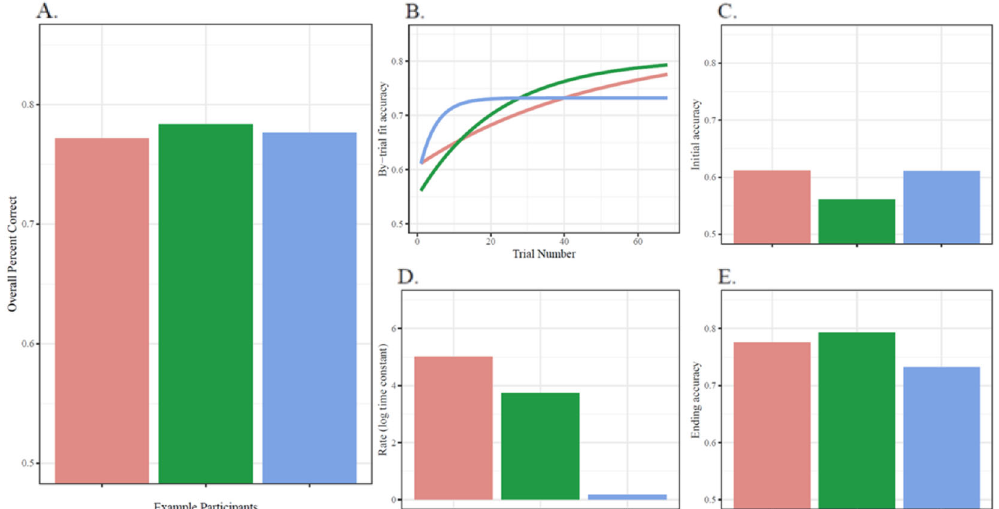
Fig. 1 Example data. WM data from three participants were selected speci fi cally to visualize certain problems with typical aggregation-based measures. Panel A shows the participants ’ similar overall average accuracy. An analysis relating overall WM performance to Gf would expect similar levels of Gf in these participants. Yet, when examining the participants ’ trajectories of performance on the WM task ( B ), they evince “ same overall performance ” in quite different ways. They differ markedly in initial accuracy ( C ), rate of change ( D ), and in fi nal accuracy ( E ). As such, more detailed theories linking WM and Gf would not make identical predictions for the three